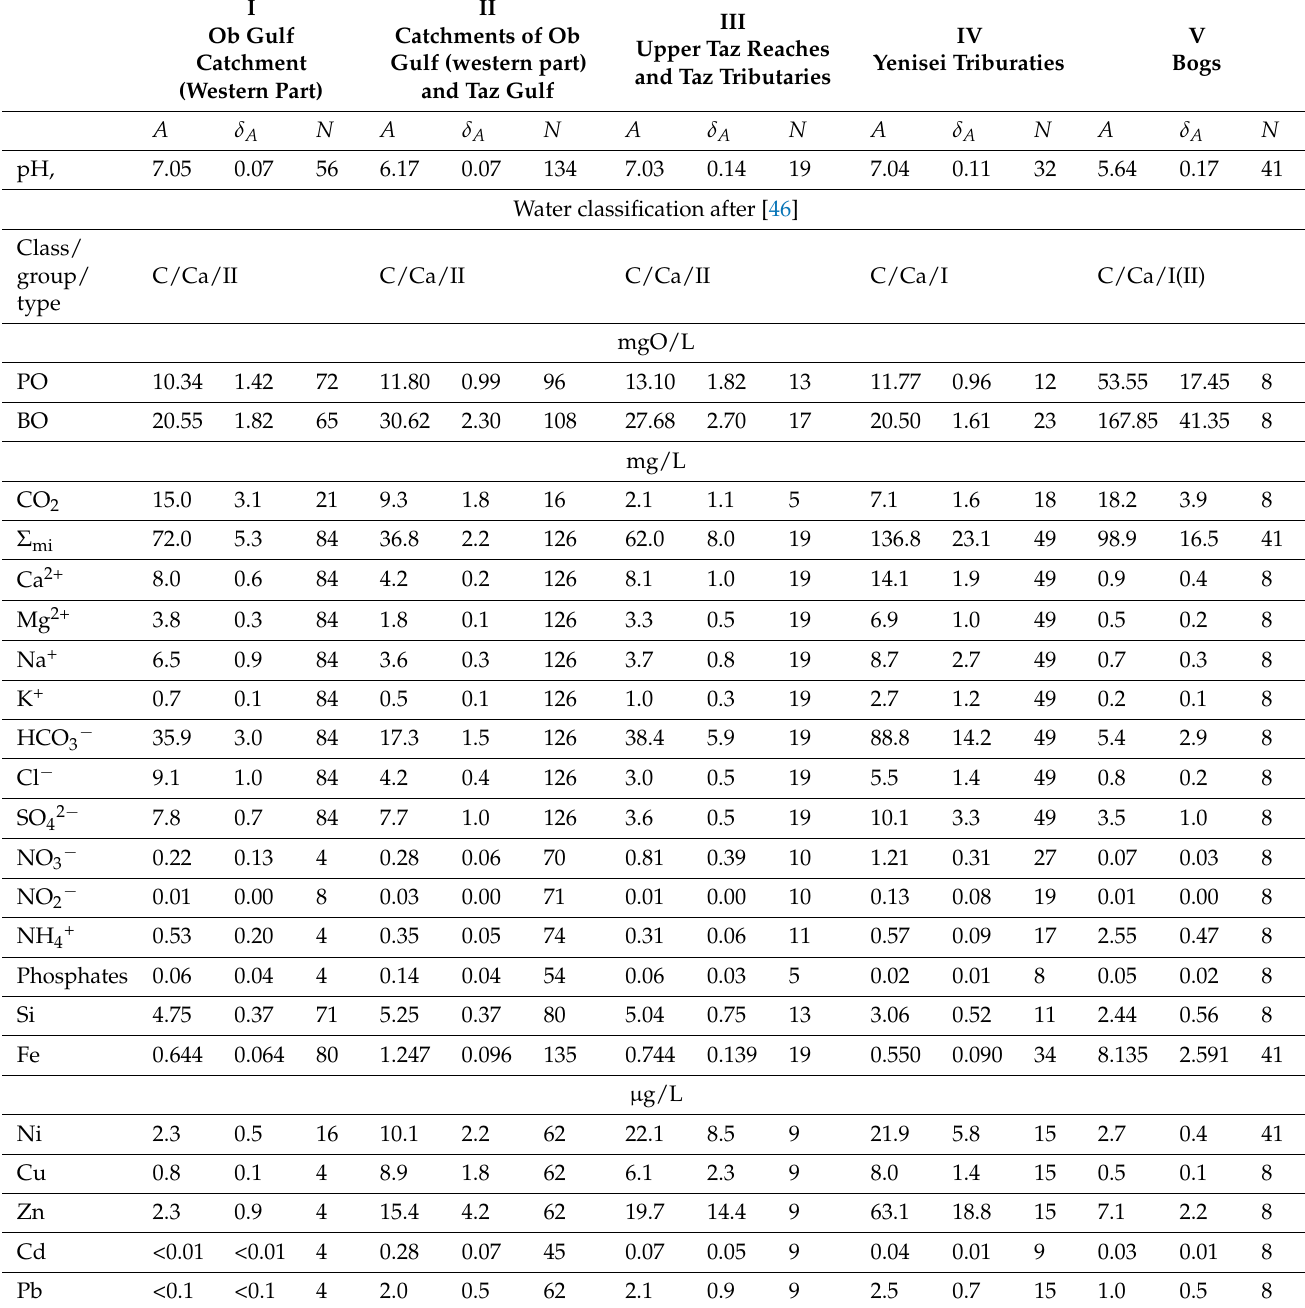
Table 3. Average values of hydrochemical parameters of river (four provinces) and bog (region as a whole)